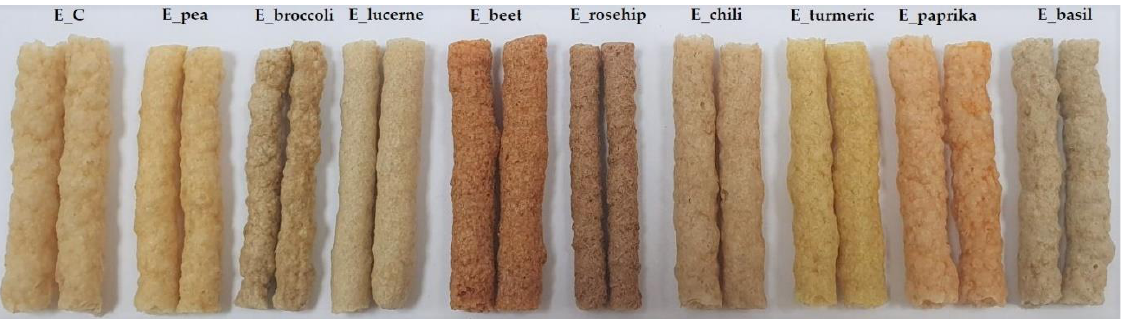
Figure 1. Appearance of the corn extrudates with different powders additions (two extrudates from each